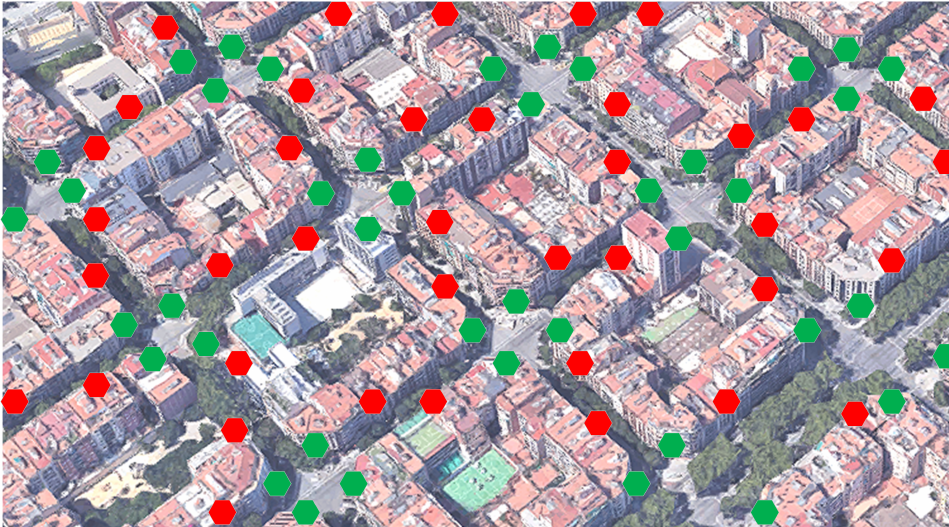
Figure 7. Example of a possible future location of sensors. Green dots indicate the location used for the experiments conducted in this paper. Red dots indicate the new proposed